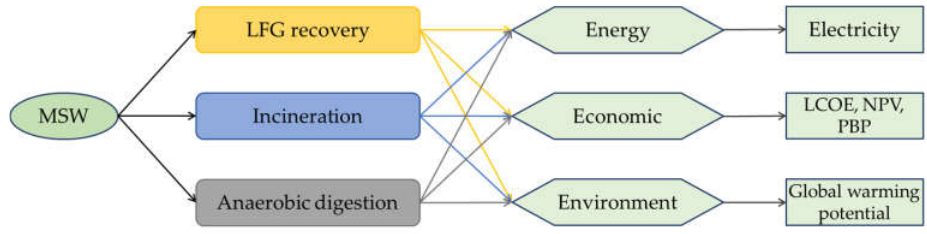
Figure 1 . Assessment framework for WTE technologies . Figure 1. Assessment framework for WTE